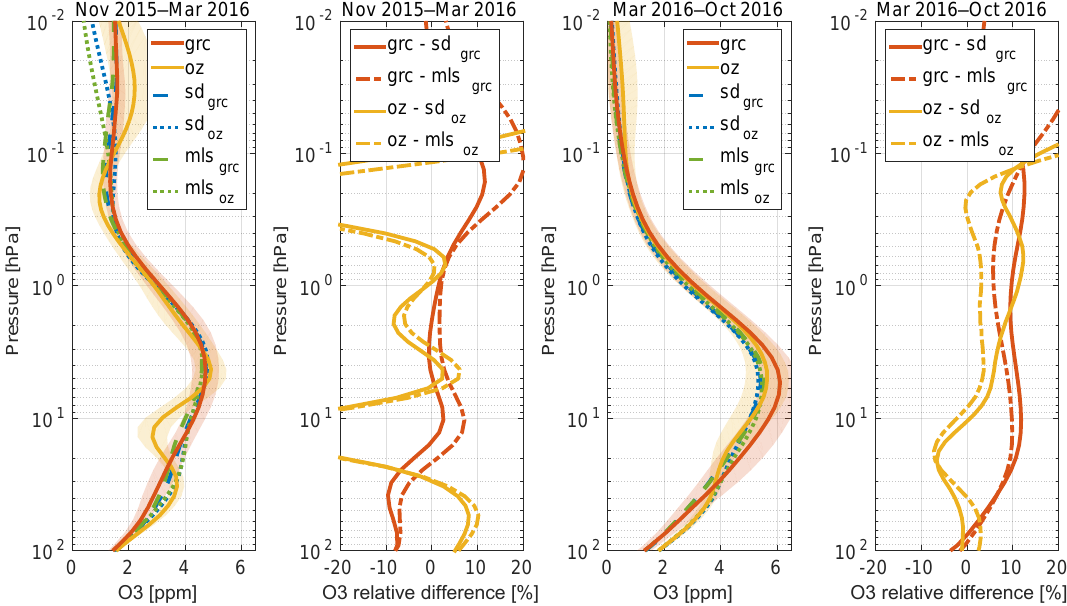
Figure 7. Ozone profiles of GROMOS-C, OZORAM, MLS and SD-WACCM at Ny-Ålesund averaged over a period in winter and a period in summer. The coloured bands indicate the standard deviation of GROMOS-C and OZORAM measurements. The MLS and SD-WACCM profiles are convolved and are labelled sd grc for a SD-WACCM profile, which is convolved with GROMOS-C averaging kernels. The relative differences of the radiometer measurements to MLS and SD-WACCM are also